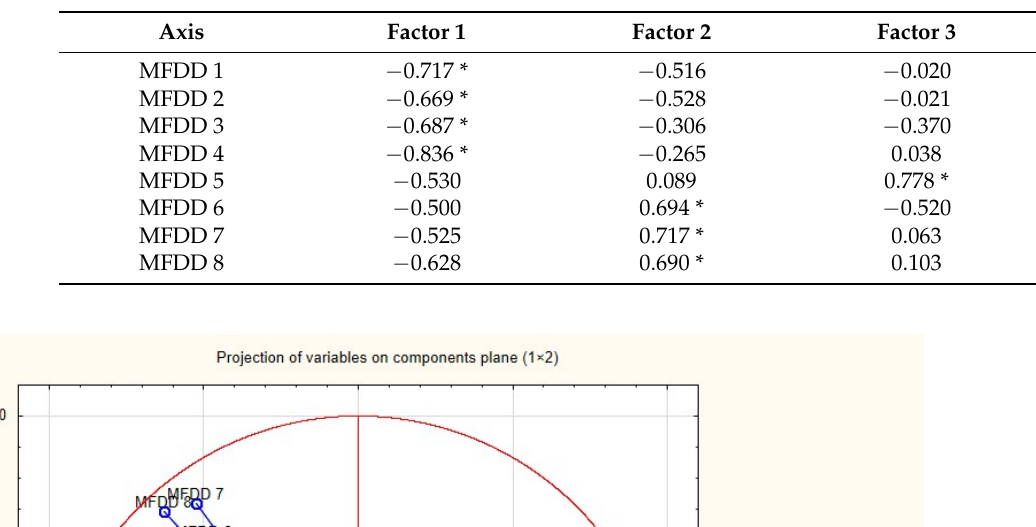
Table 3. Factor loads of individual variables. Loads with correlation with component greater than 0.6 are marked with *.